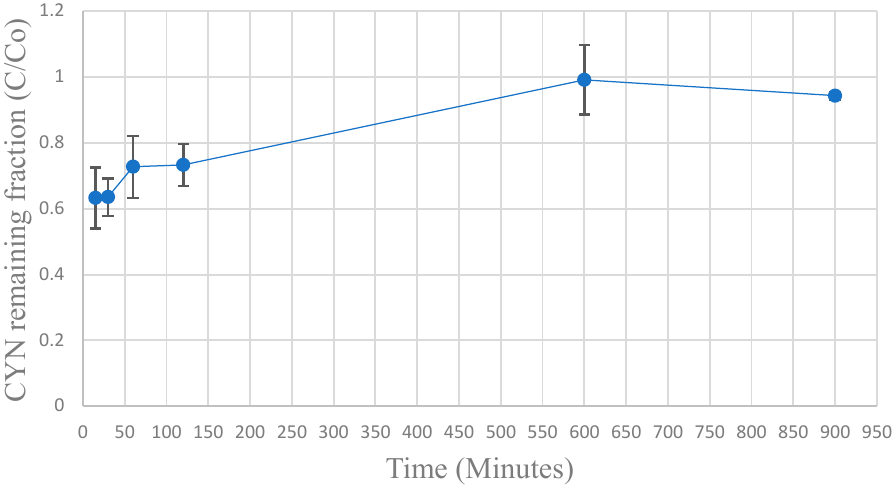
Figure 9. CYN breakthrough curve obtained in SBA tests—Average values of CYN remaining fraction in the effluent. The bars represent the standard deviations of average values.